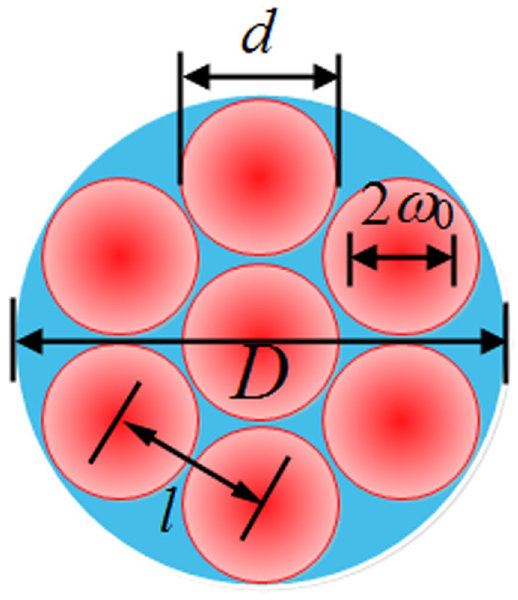
Figure 1. The diagram of a tiled combining beam